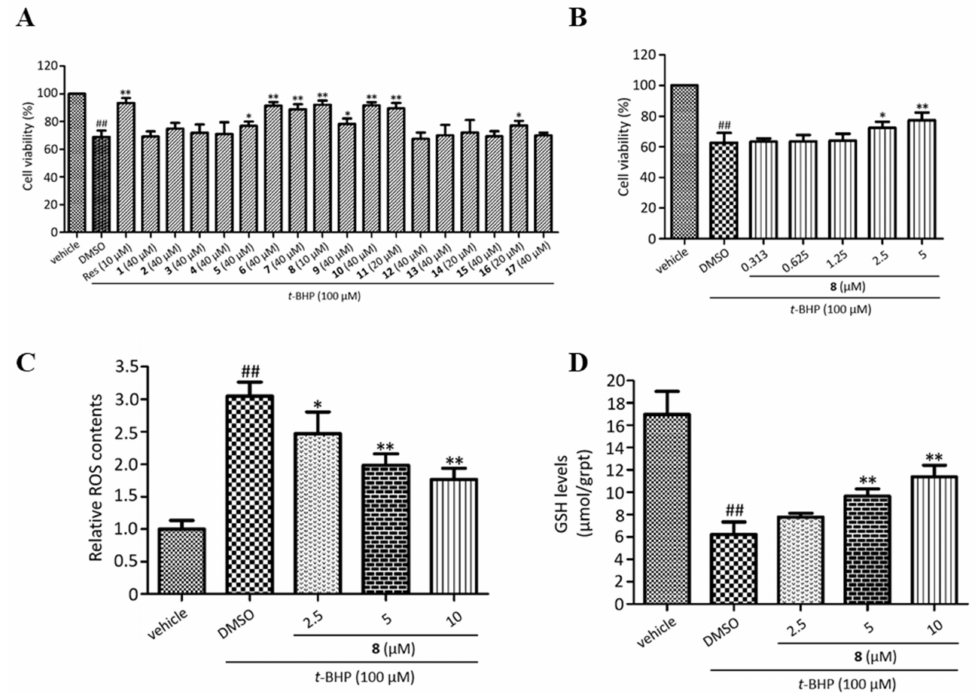
Figure 10. Hepatoprotective effects of withanolides on t -BHP-injured AML12 hepatocytes. ( A ) Cell viability of t -BHP-injured AML12 hepatocytes treated with compounds 1 – 17 at their maximum safe concentration. Resveratrol (Res) at 10 µ M was used as a positive control. ( B ) Cell viability of t -BHP-injured AML12 hepatocytes treated with different concentrations of compound 8 . ( C ) ROS contents in t -BHP-injured AML12 hepatocytes treated with different concentrations of compound 8 . ( D ) GSH levels in t -BHP-injured AML12 hepatocytes treated with different concentrations of compound 8 . Data are shown as mean ± S.D., n = 3. ## p < 0.01 vs. vehicle; * p < 0.05 and ** p < 0.01 vs. t -BHP plus